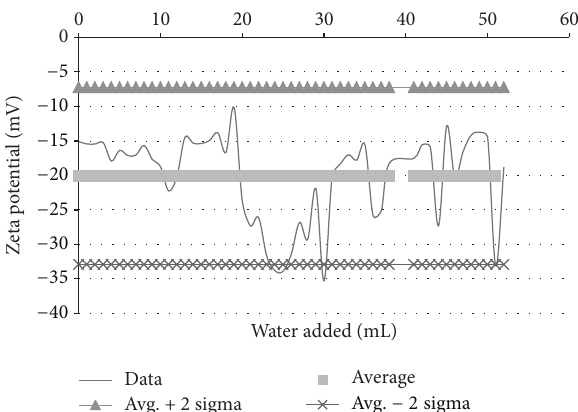
Figure3:Zetapotentialmeasurementsforlimestone-oilsuspension with volume of water added.